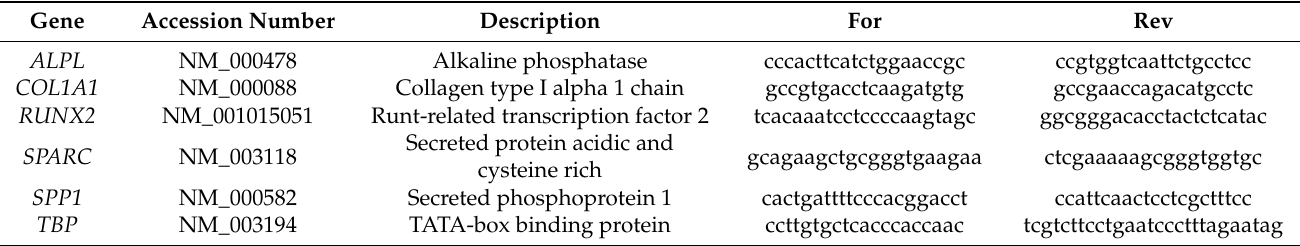
Table 2. Sequences of primers used for real-time